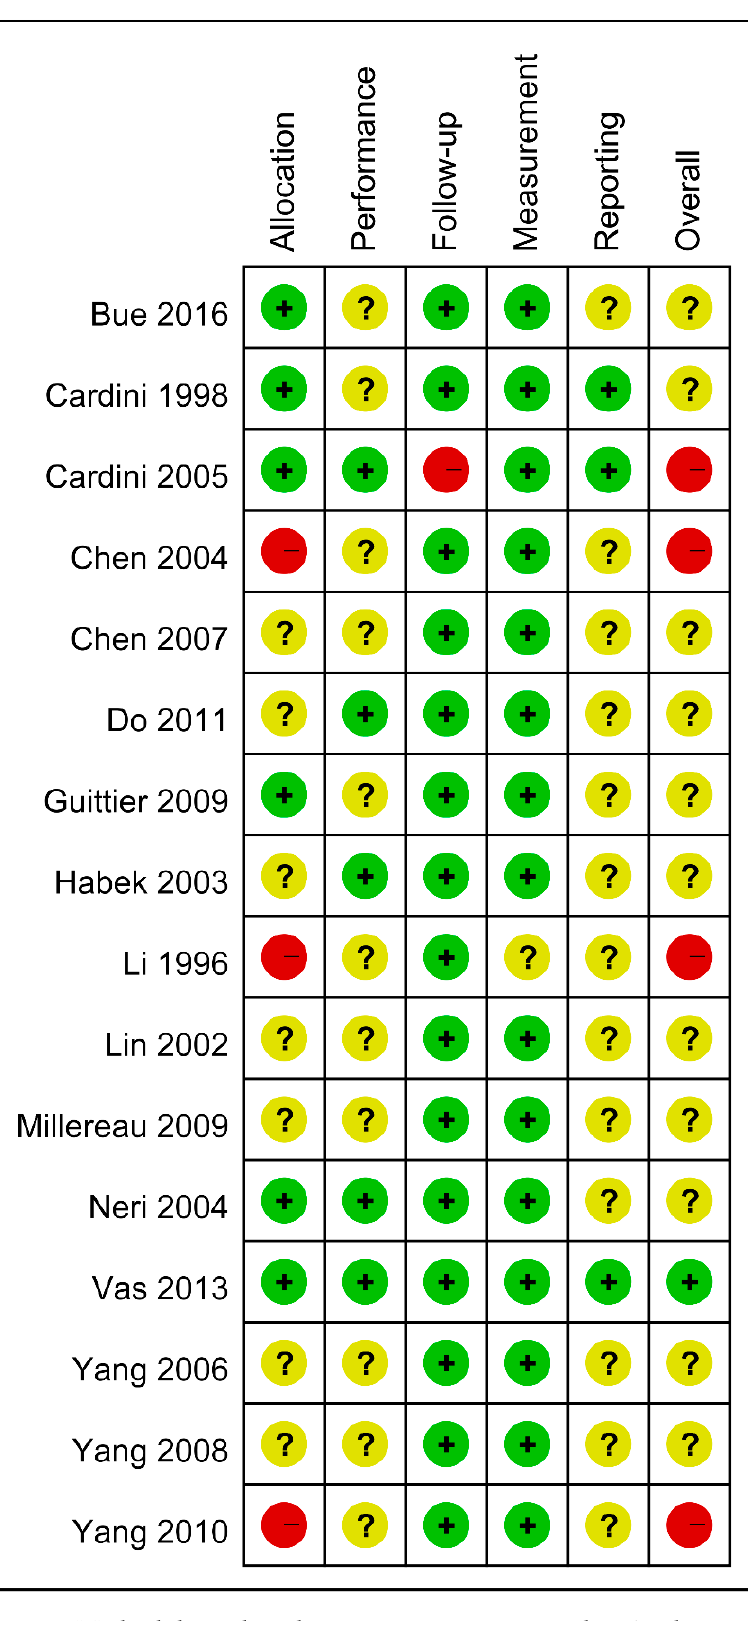
Figure 2. Methodological quality summary: reviews authors’ judgement on each methodological quality item for each included study.